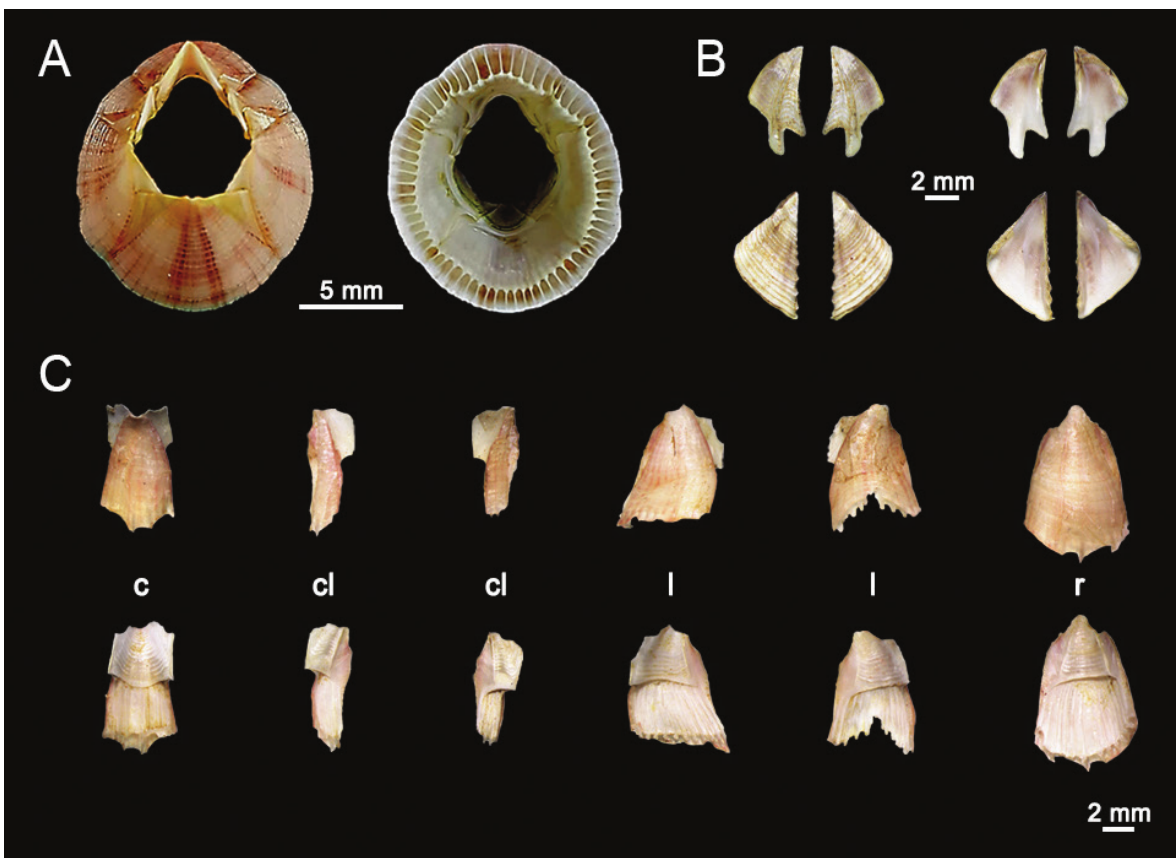
Figure 10. Amphibalanus reticulatus collected from Si Racha beach, Chon Buri (BUU16.BN.AR01, A ; BUU16.BN.AR 03, B & C ). A. Dorsal and ventral view of external shell, B. External (left panel) and internal (right panel) view of tergum (upper panel) and scutum (lower panel), C. External (upper panel) and internal (lower panel) view of shell plates. Abbreviations: c, carina; cl, carinal latus; l, latus; r,